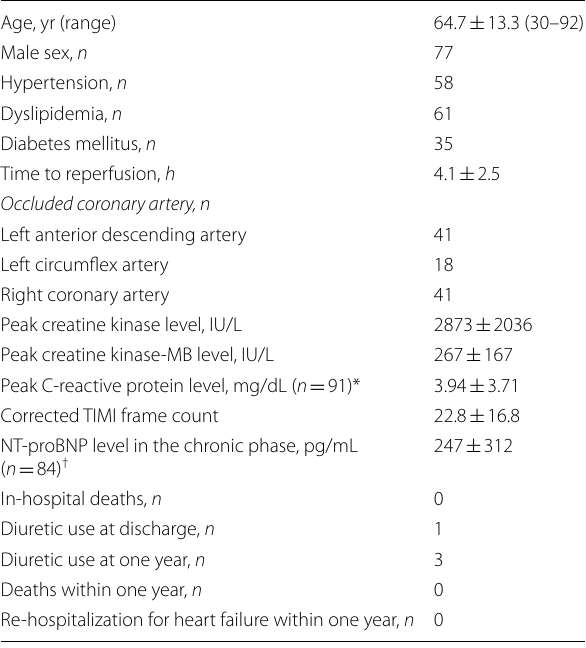
Table 1 Clinicodemographic characteristics and outcomes of the study patients ( N =